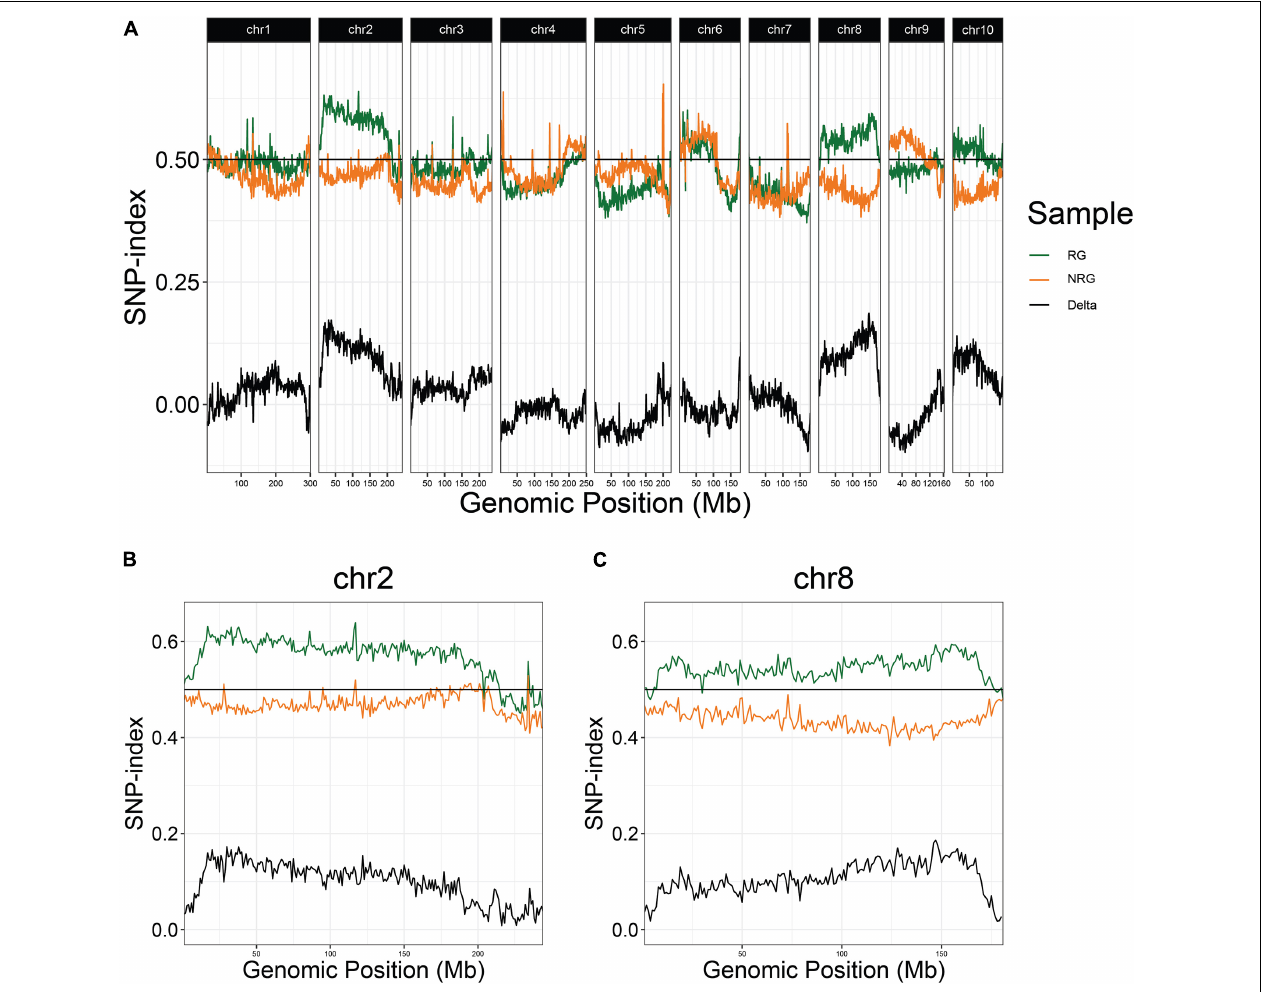
FIGURE 2 | QTL-seq for regrowth reveals two major loci in a P39/“Gigi” F 2 population. (A) Average SNP-index per 1 Mb window is plotted across all ten chromosomes. Chromosomes 2 (B) and 8 (C) are shown in greater detail. For each plot, lines display SNP-index of regrown (RG) bulk in green, non-regrown (NRG) bulk in orange, and the difference between the two bulks (RG – NRG) in black.